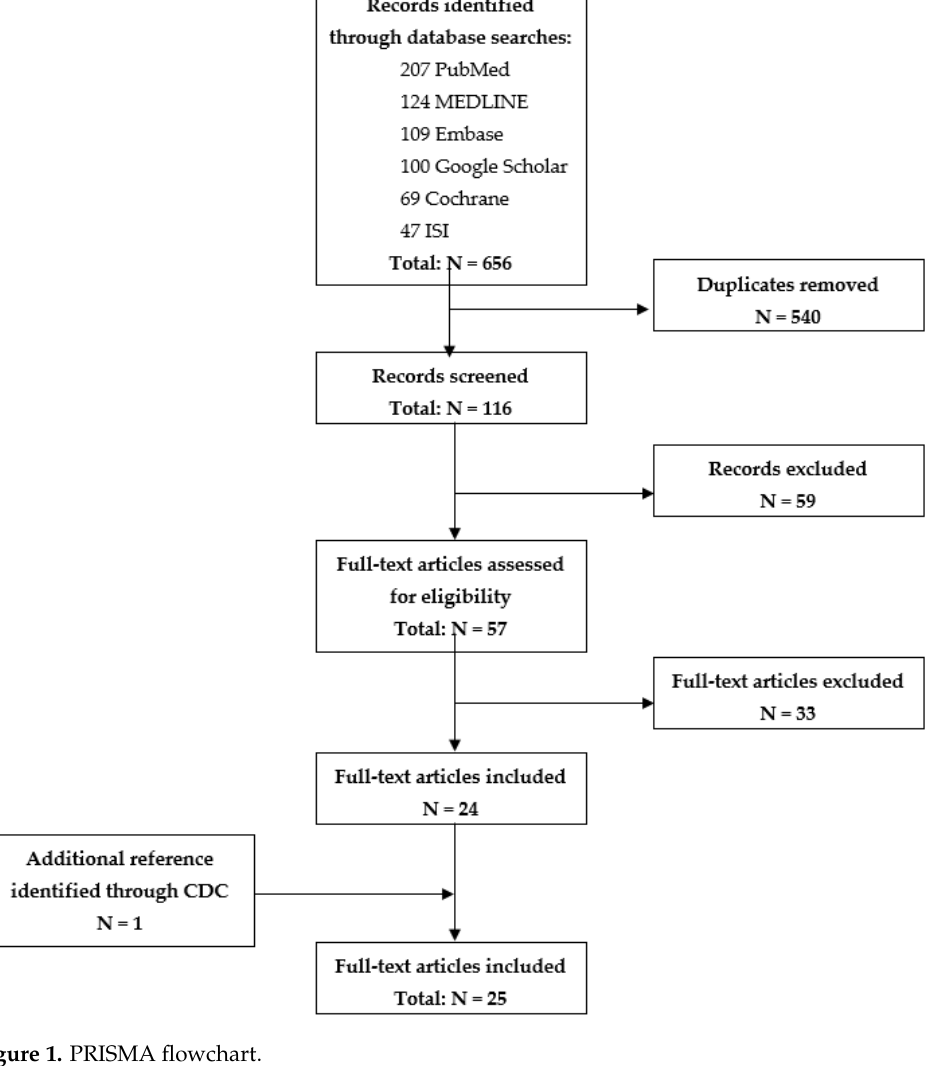
Figure 1. PRISMA flowchart.